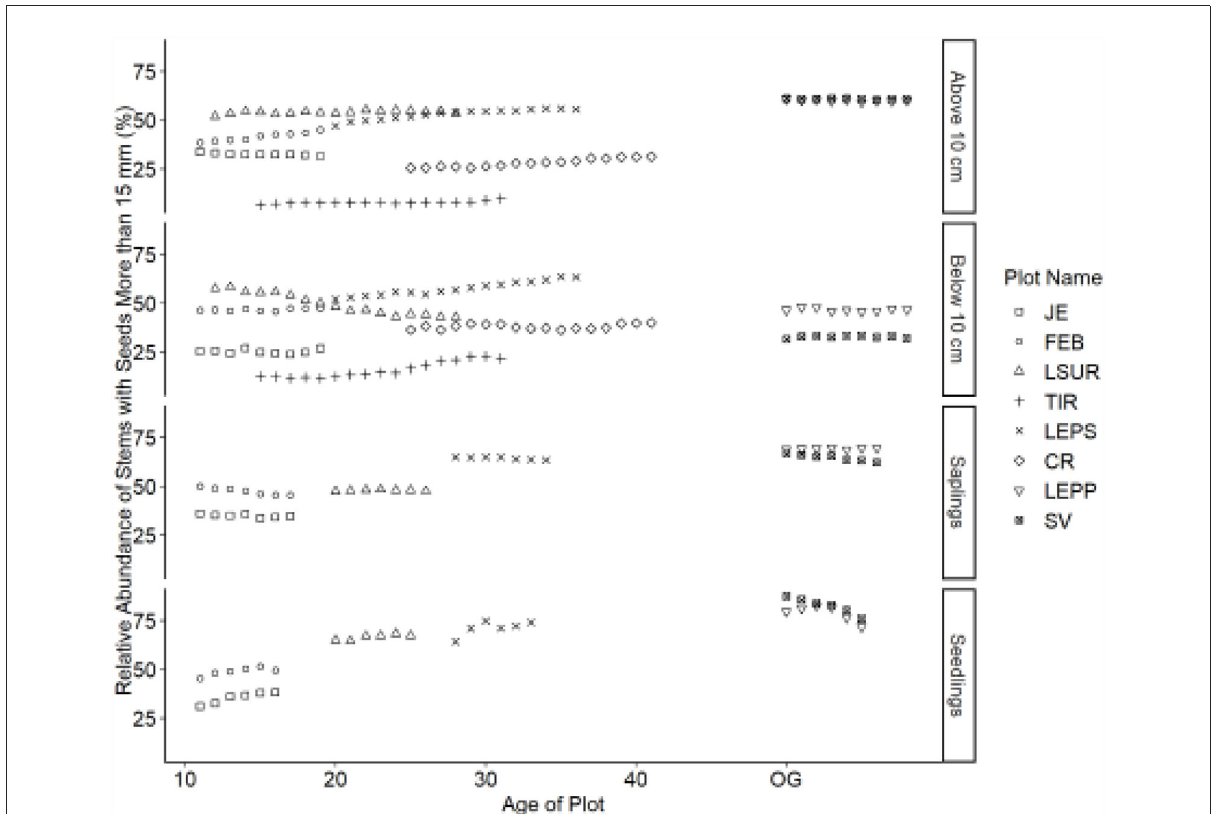
FIGURE6 Relative abundance of stems with seeds y > 15mm (large) category. Table 1 indicates the plot acronyms, which appear from youngest to oldest, top to bottom in the